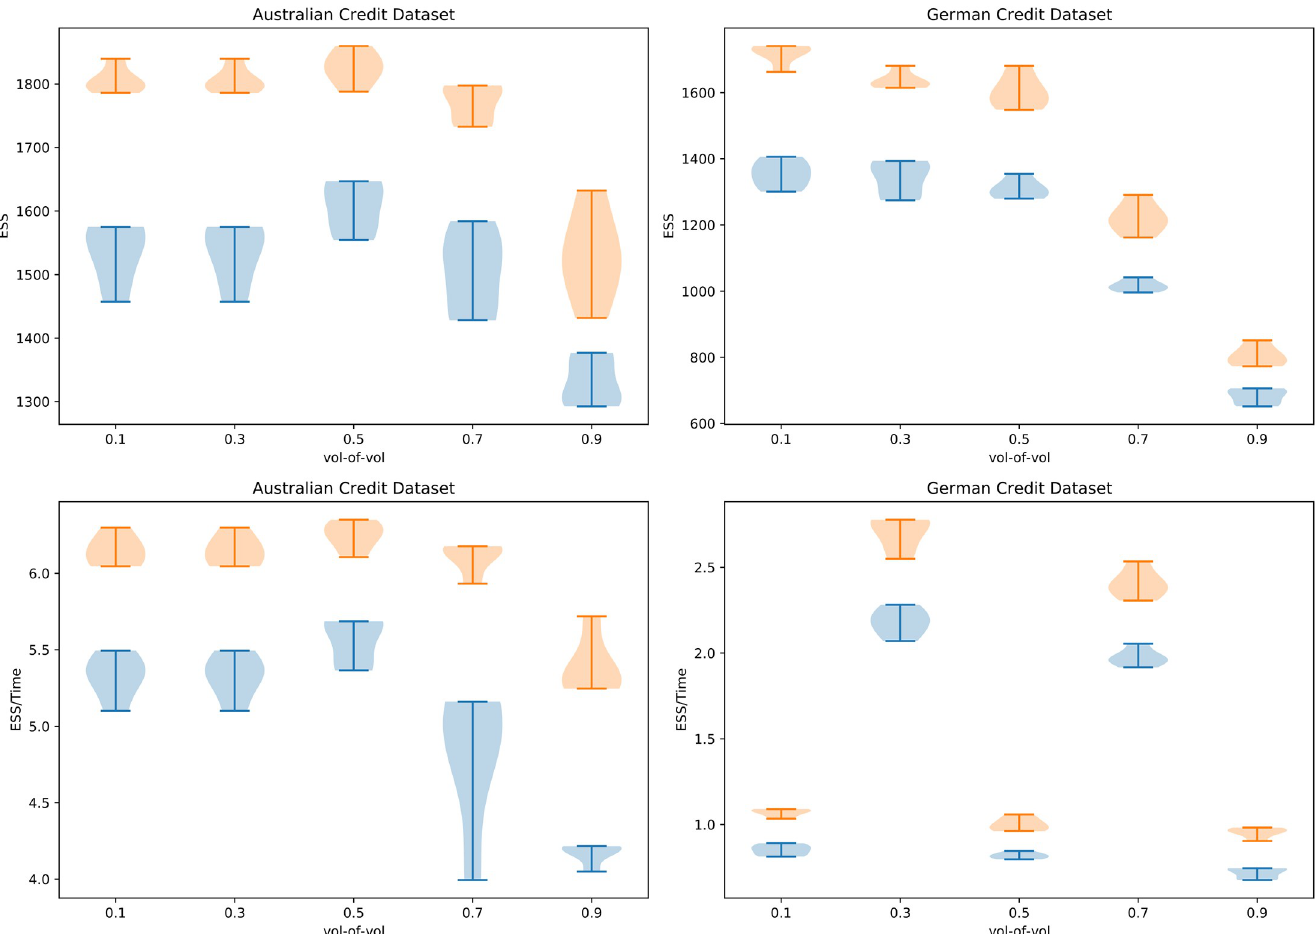
Fig 1. ESS and ESS/ t for ten runs of QIHMC (blue) and QIMHMC (orange) on the Australian and German credit datasets with varying choices of the vol-of-vol parameter.